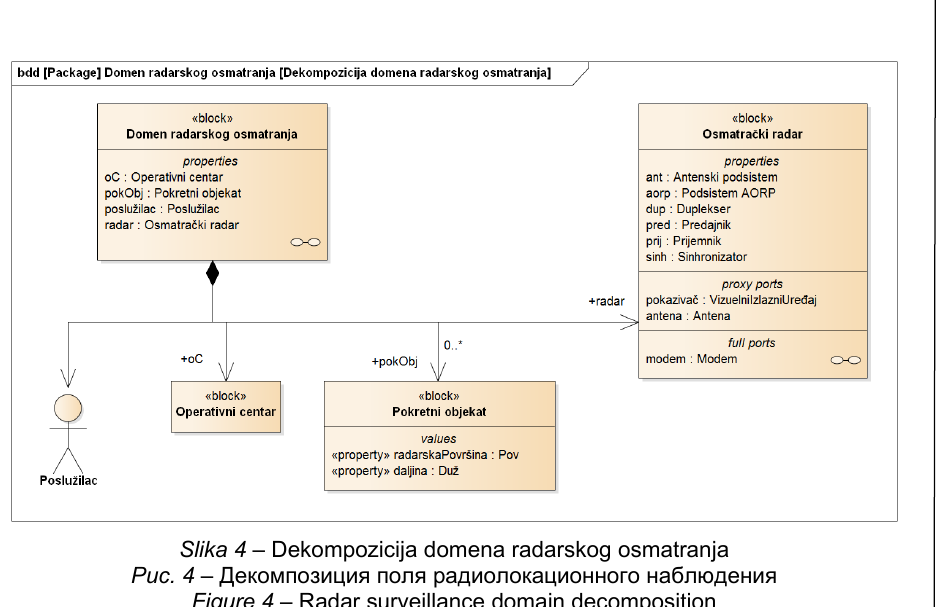
Figure 4 – Radar surveillance domain